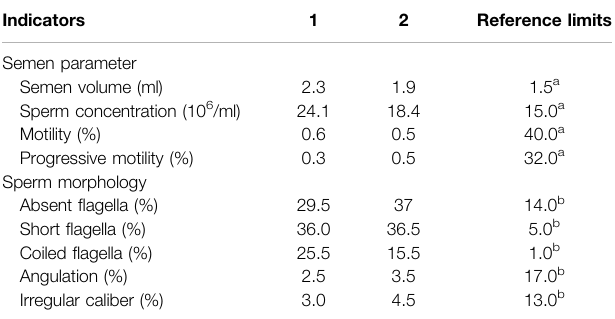
TABLE 1 | Semen characteristics and sperm morphology in men harboring CFAP251